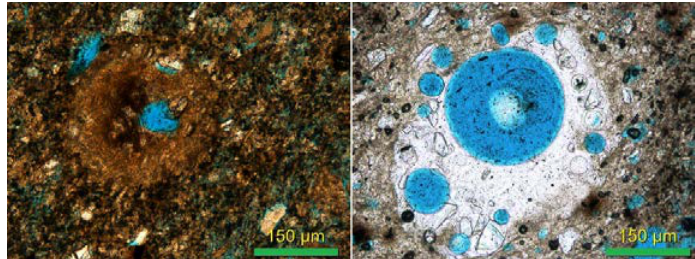
Figure 11. The minimum orthogonal Feret diameter/maximum Feret diameter, a measure of pore elongation, decreases with higher firing temperatures. Points are mean of 2.